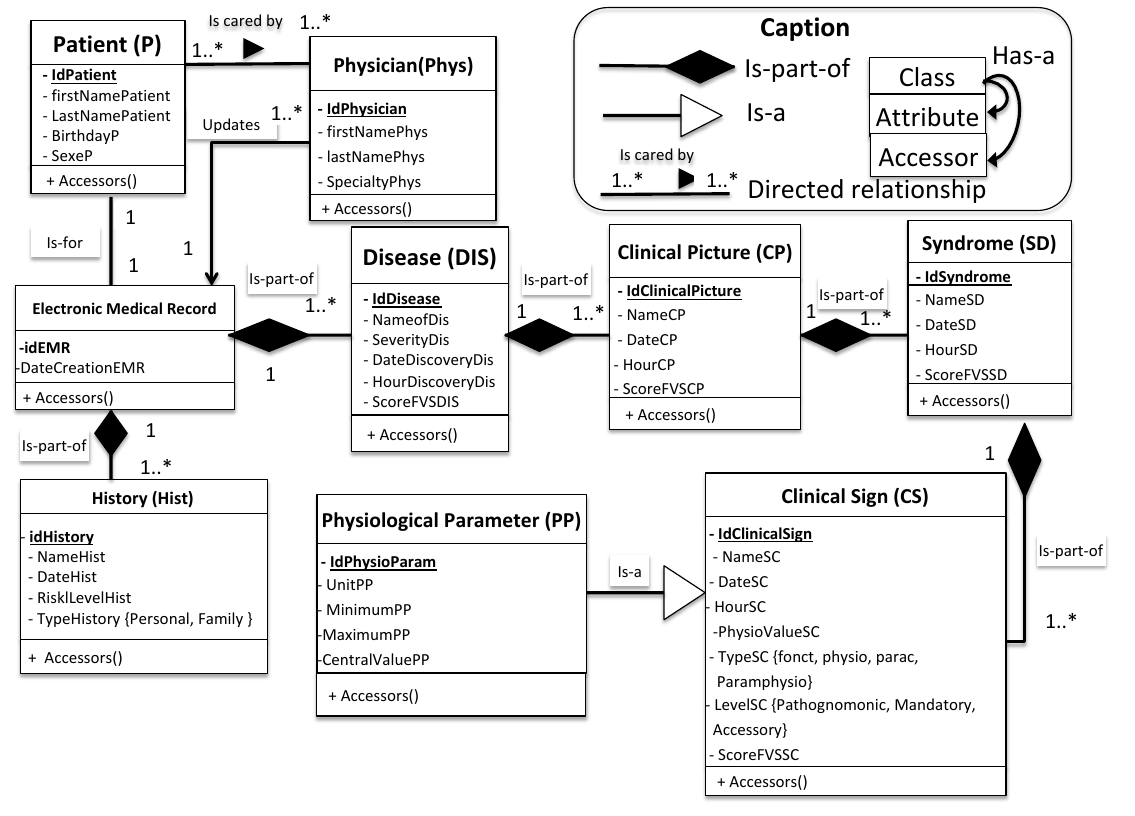
Figure 15. The UML disease diagram.